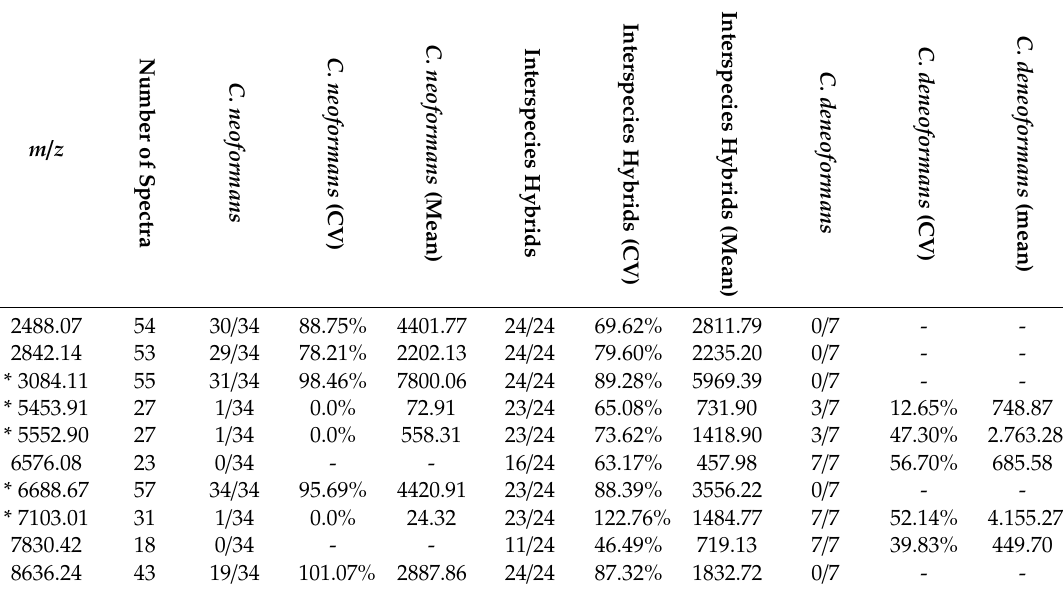
Table 2. List of the 10 representative mass peaks of Cryptococcus spp. identified as potential biomarkers. These peaks were used for the construction of dendrograms and PLS-DA and SVM models. The 5 peaks marked with asterisks (*) were selected for the simplified models. CV = coe ffi cient of